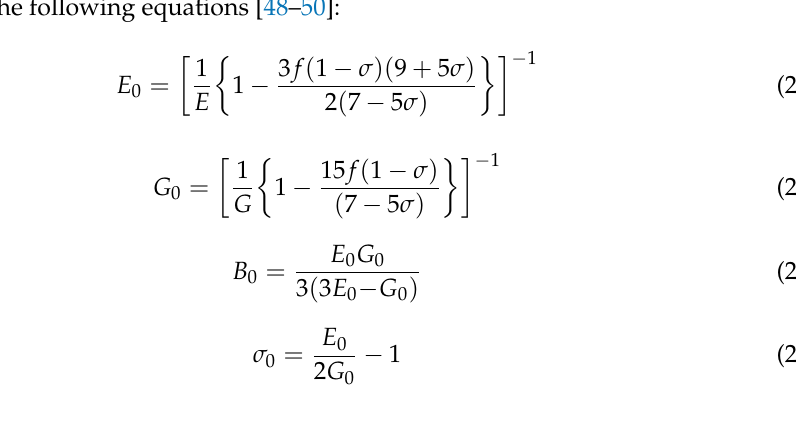
where v av = ( v 1 + v 2 ) /2. Substitution of Dy 3+ for Fe 3+ ions increase the θ D from 540 to 565 K (Table 4). The increase in θ D could be related to the increment in the P-type conduction in the CoCr 0.5 Dy x Fe 1.5 − x O 4 [51]. The corrected porosity (zero porosity) was obtained by putting the values of porosity fraction ( f ) in the following equations